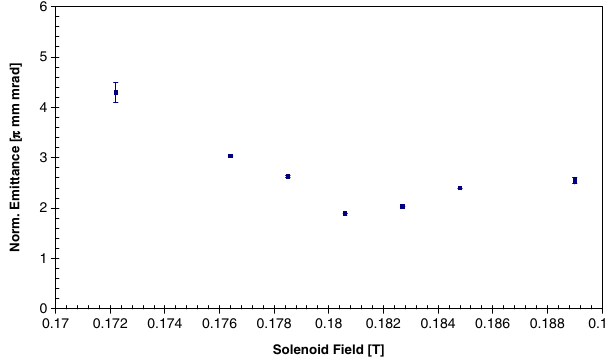
FIG. 9. Solenoid field scan for emittance minimum. The emit- tance was measured by the quad scan method. The charge per bunch was 1